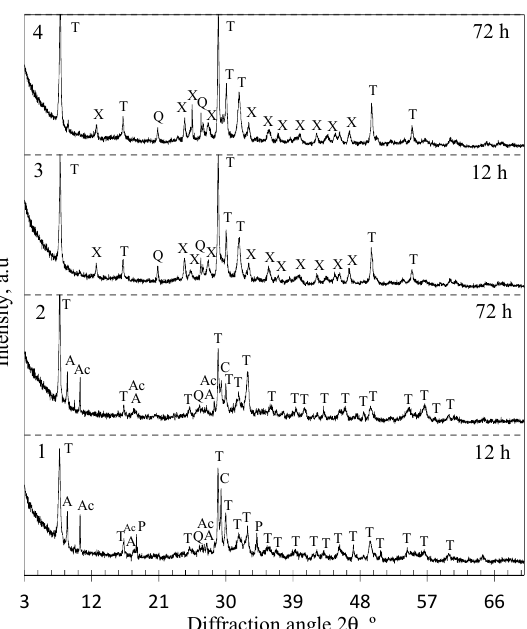
Figure 1. XRD patterns of the synthesis products from lime–GSW (patterns 1, 2) and lime–calcined opoka (patterns 3, 4) mixtures with CaO/SiO 2 = 1.0 at 200 °C. Indexes: A—annite, Ac—actinolite, C—calcite, P—portlandite, Q—quartz, T—1.13 tobermorite, X—xonotlite. By extending the synthesis duration to 72 h, the intensity of peaks characteristic to the main synthesis product 1.13 nm tobermorite increases significantly (Figure 1, curve 2), while the intensity of the main peak ( d = 1.13 nm) increases in value from 409 to 1094 cps (Figure 2). In addition, under these synthesis conditions crystallite size (determined by Scherrer method) of 1.13 nm increases from 40.9 nm (after 12 h of curing) to 52.1 nm (after 72 h of curing), which is almost three times higher (Figure 3). However, a huge amount of Al 3+ ions presented in raw mixture prevents the formation of xonotlite, despite the fact that the composition of the mixture corresponds to its stoichiometry, and the synthesis temperature is optimal for the crystallization of this compound. A similar phenomenon has been observed previously in the synthesis of gyrolite and other calcium silicate hydrates [38]. In addition, the annite and actinolite presented in the GSW do not react and remain in the synthesis products even after 72 h of isothermal current.